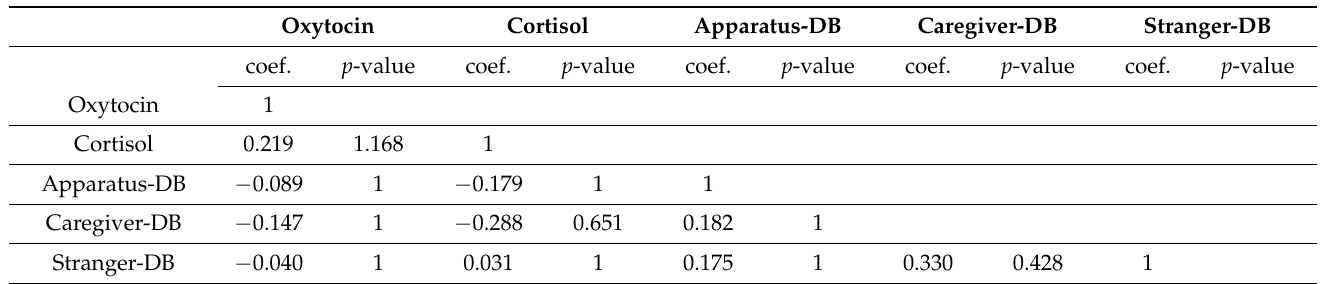
Table 3. Spearman correlations between oxytocin, cortisol, and behavioral variables (frequency). Asterisks indicate a significant correlation. Sample size: 25 calves.